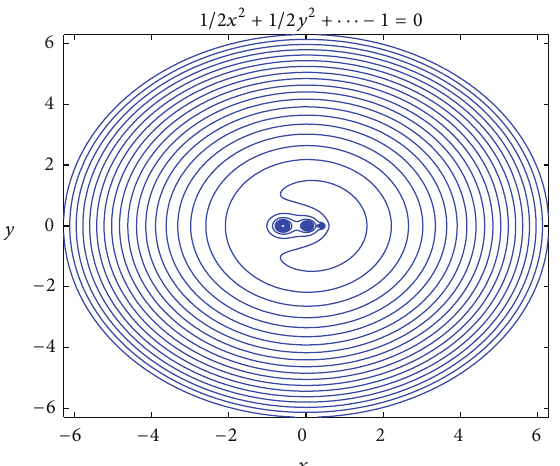
Figure 6: Curve of zero velocity (Archid-1) 𝑞 1 = 0.9971 , 𝑞 2 = = 0 , 𝐴 = 0 . 0.9997 , and 𝐴 1 2